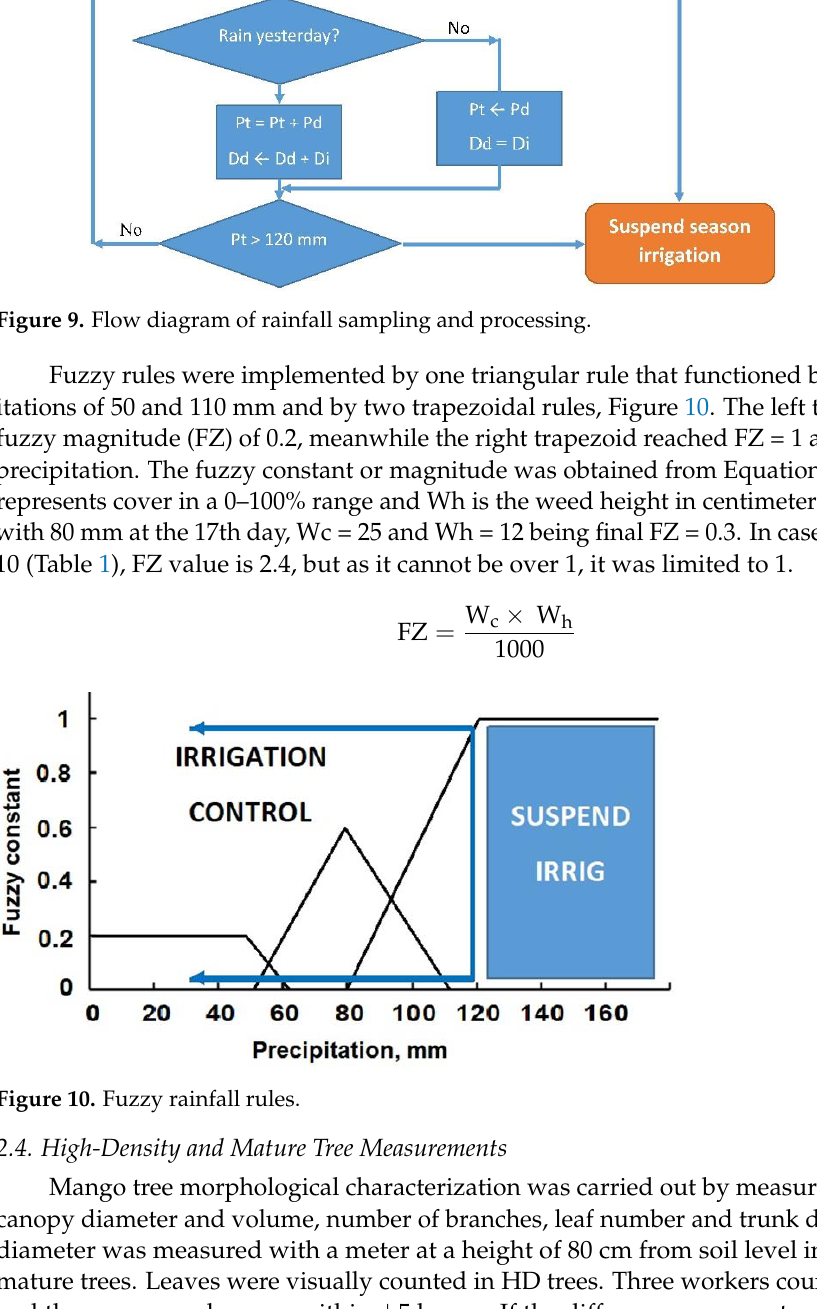
Figure 10. Fuzzy rainfall